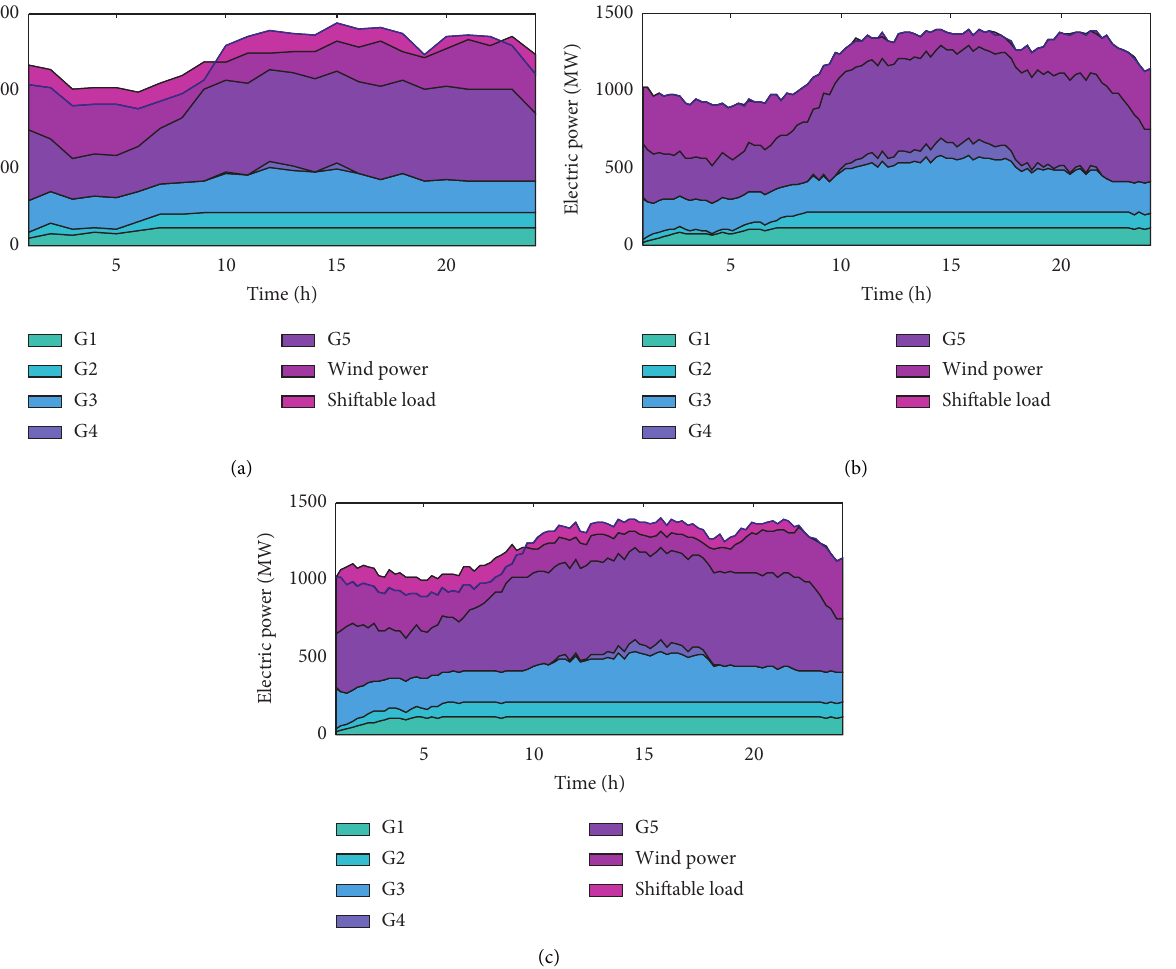
Figure 5: Scheduling results of different resources. (a) Method 1. (b) Method 2. (c) Method 3 (the proposed